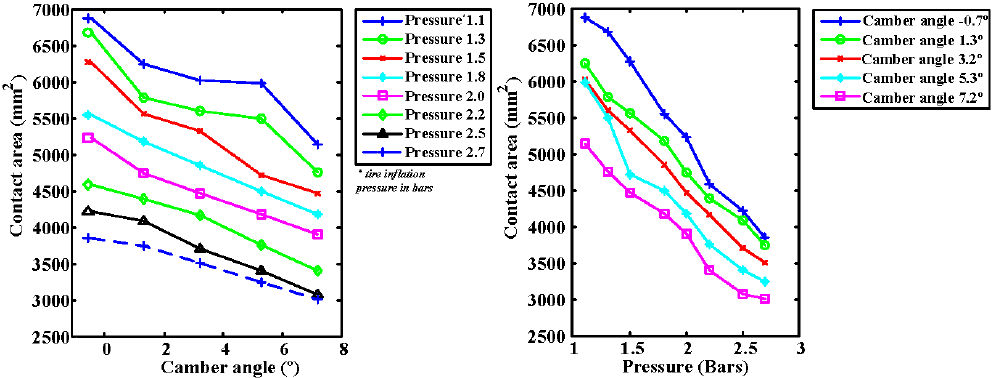
Figure 13. Contact area: vs. camber angle ( left ); and vs. tire inflation pressure ( right ).